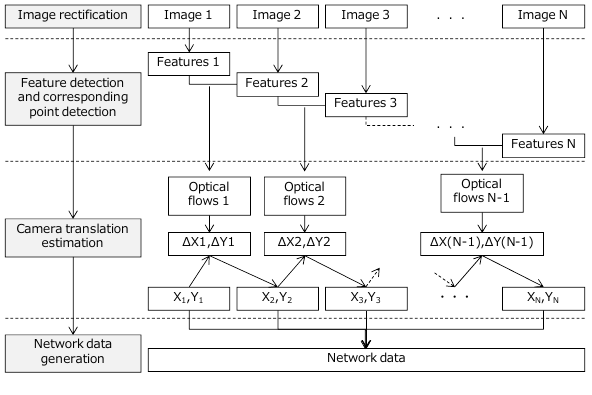
Figure 1. Processing flow